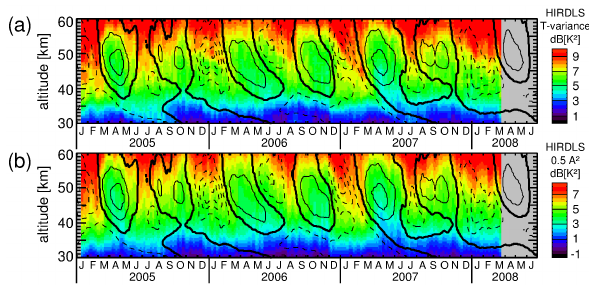
Figure B1. Altitude–time cross sections of HIRDLS gravity wave (a) temperature variances (no vertical window applied), and (b) squared temperature amplitudes determined in 10km vertical windows from the HIRDLS altitude profiles. Values in (b) were divided by 2 to be comparable to the variances in (a) . Units in (a) and (b) are dB(K 2 ). Values in (a) and (b) are averages over the latitude band 10 ◦ S–10 ◦ N. Contour lines indicate the zonal wind: westward wind is dashed, and the bold contour line indicates zero wind. Contour increment is 20ms − 1